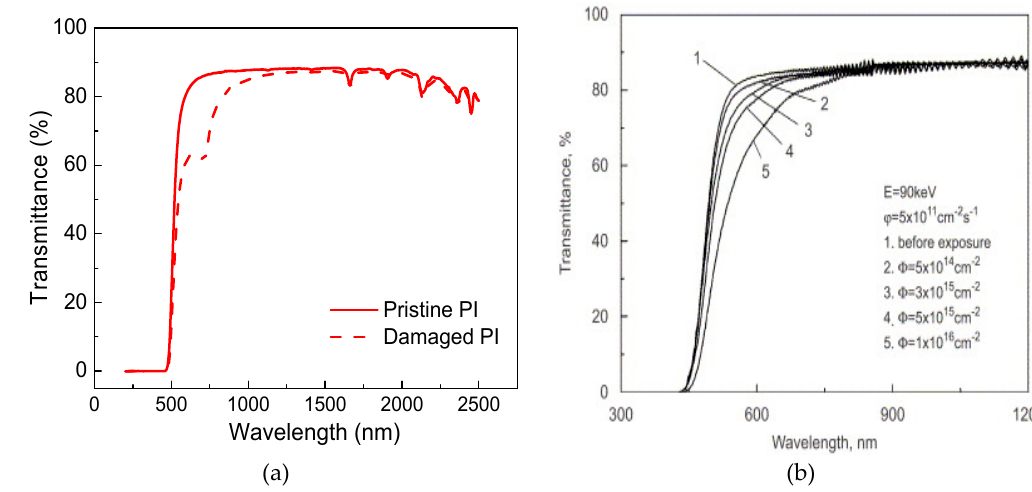
Figure 4. Representative transmittance spectra of PI irradiated with ( a ) 90 keV electrons with fluence of 1.7 × 10 7 Gy and ( b ) 90 keV protons with different fluences. Adapted with modifications from [142] and [104], respectively.